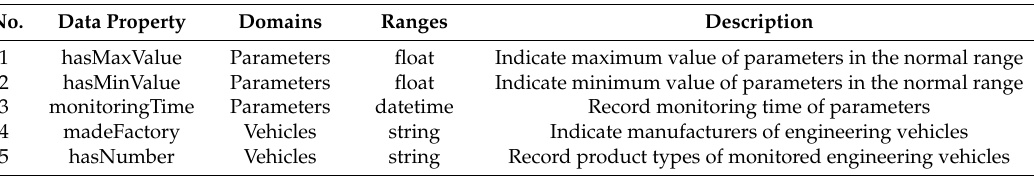
Table 1. Data properties in the rollover ontology model.